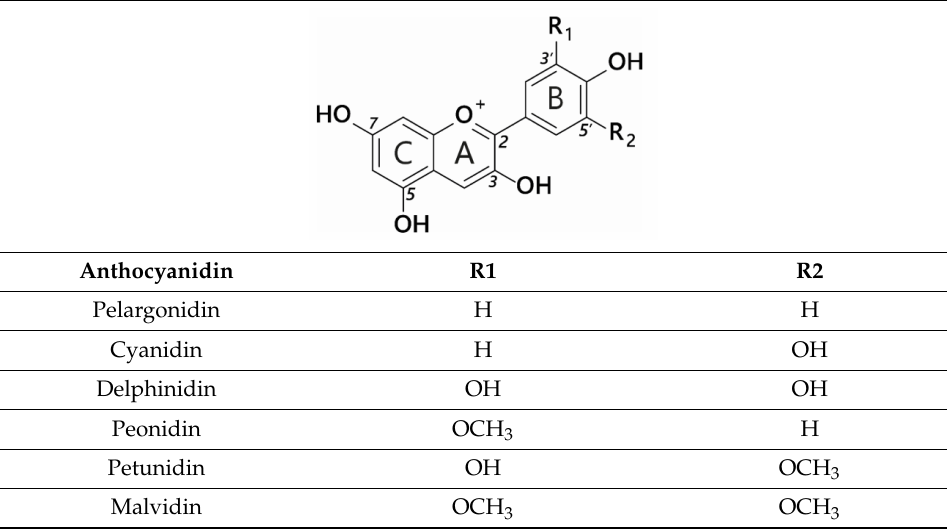
Table 1. General structures of common